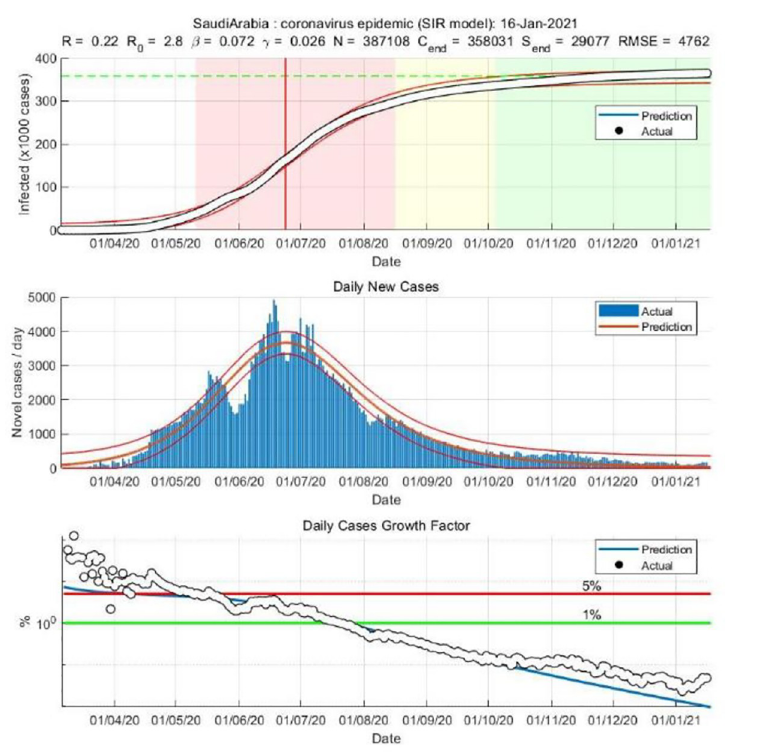
Fig 7. SIR model based on post-lockdown data (until January 16,